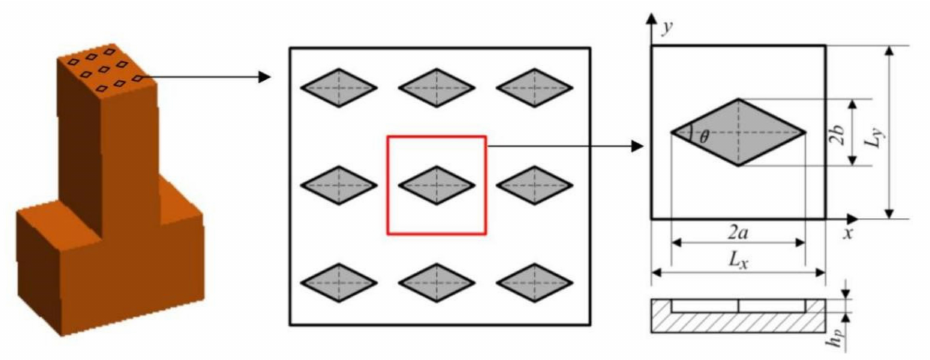
Figure 7. Micro textures on the surface of MSMA auxiliary support